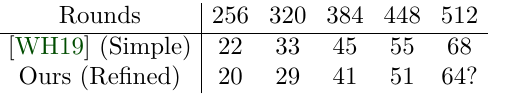
Table 11: Score of the best Type 1 trail found for number of rounds evaluated by the original submission document. Question mark (?) signifies that the solver didn’t finish.